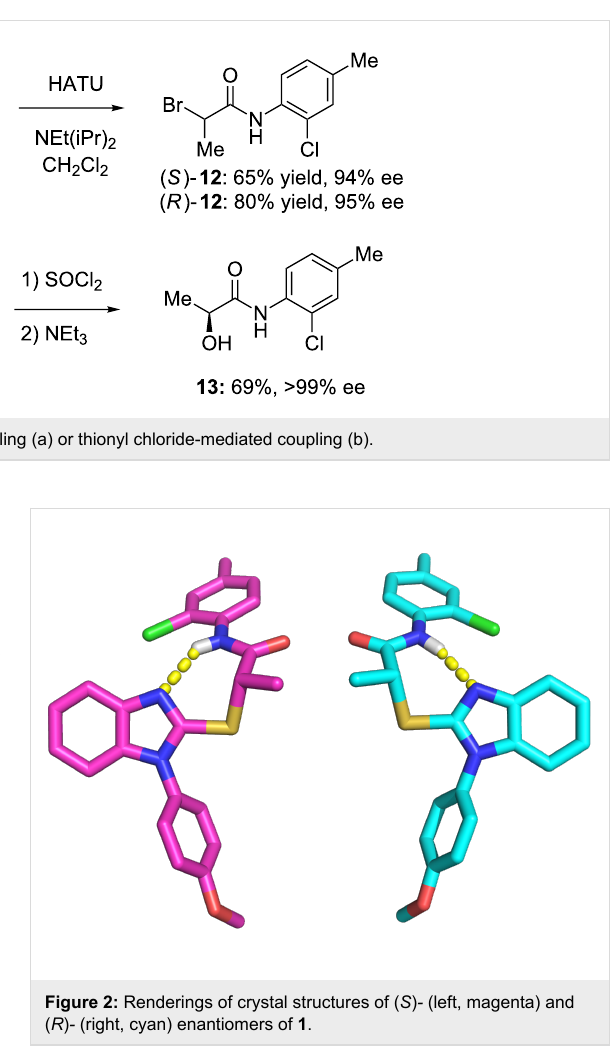
improve solubility compared with the parent. Several